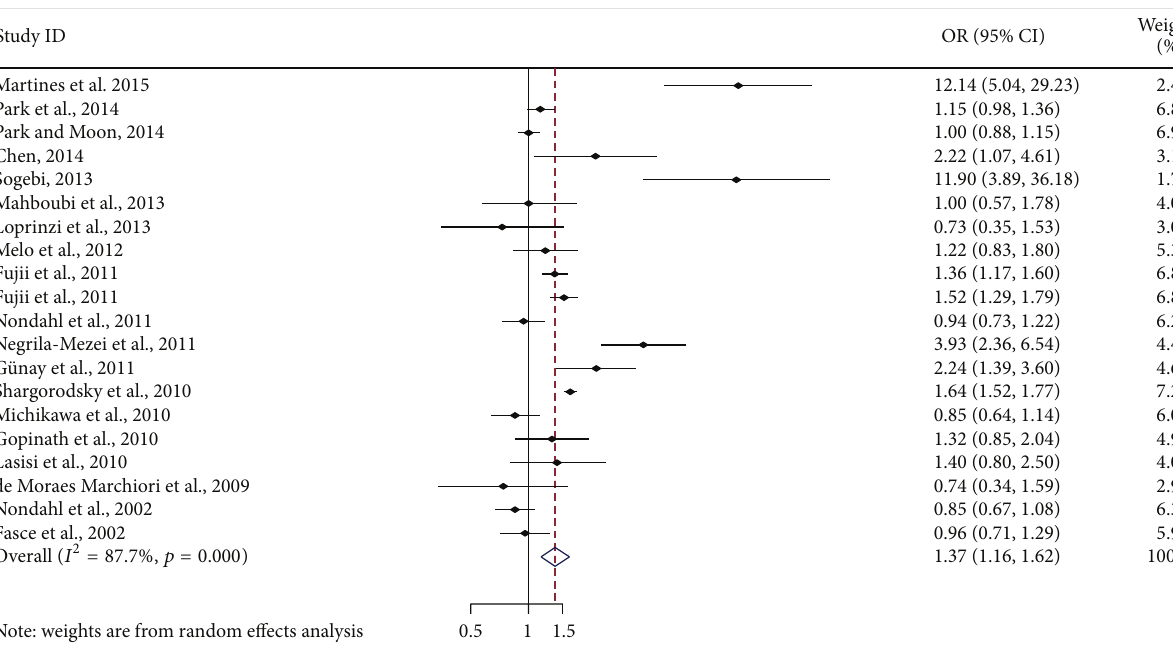
Figure 2: Forest plot of the associations between hypertension and tinnitus (OR and 95% CI indicate odds ratio and 95% confidence